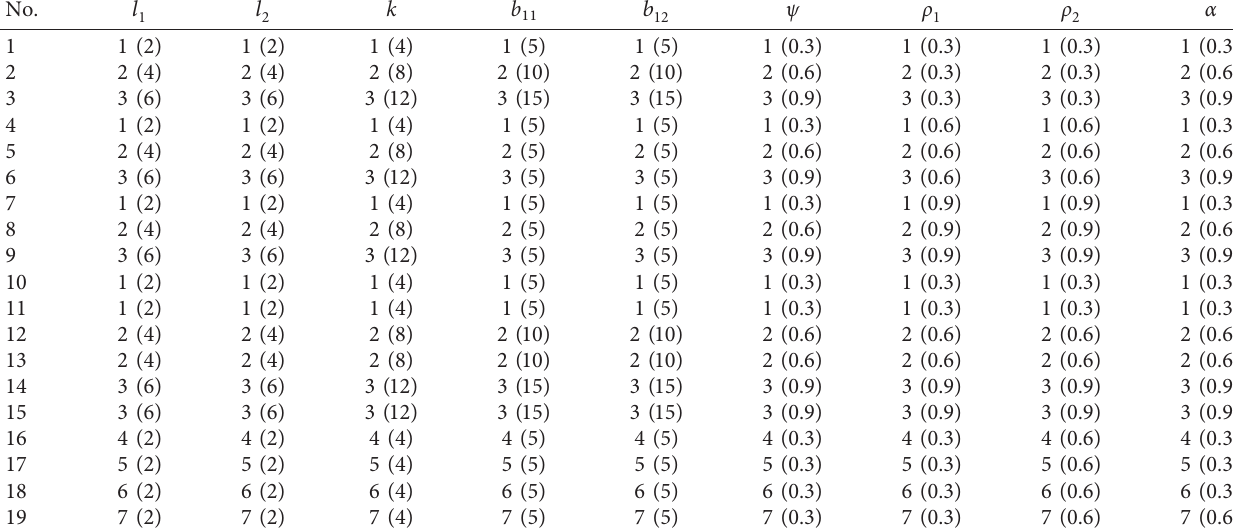
Table 6: The simulation